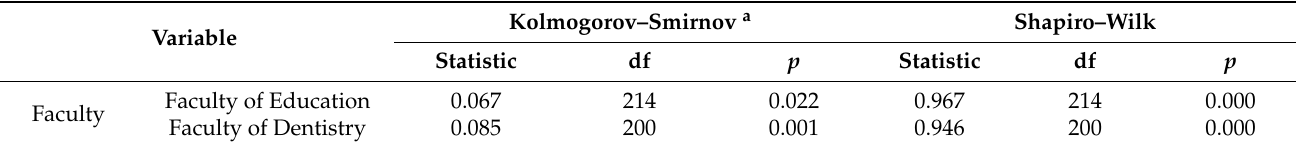
Table 3. Normality test results in terms of gender and faculty.